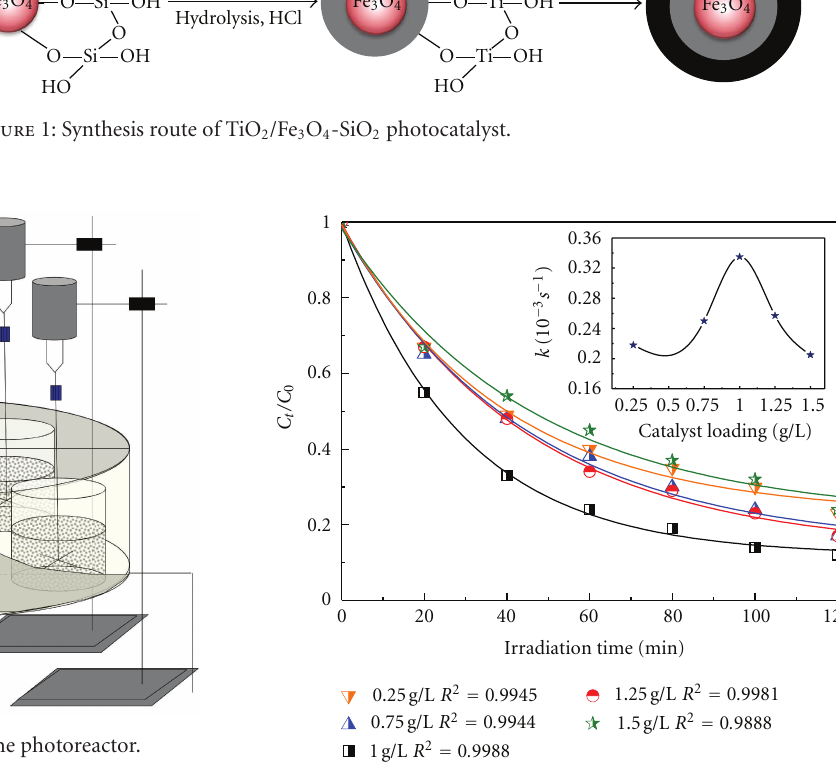
Figure 3: E ff ect of TFS catalyst loading on the degradation of naph- thalene. Inset graph: rate constant ( k ) versus TFS catalyst